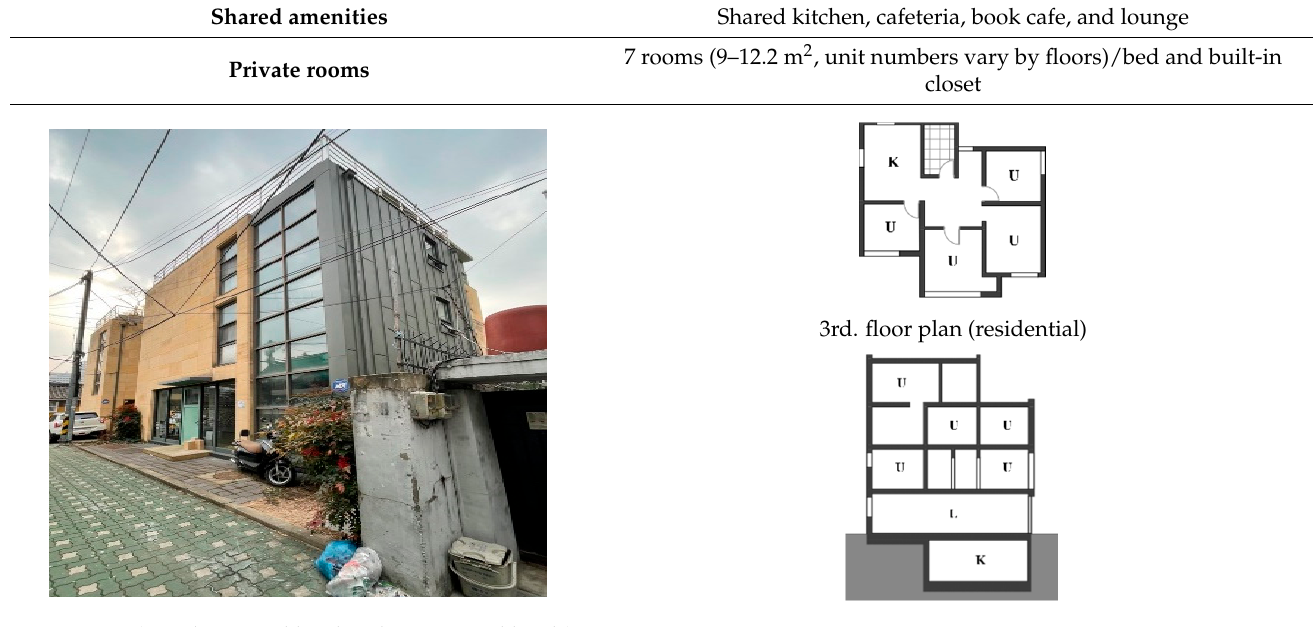
Table 5. Micro housing [23].